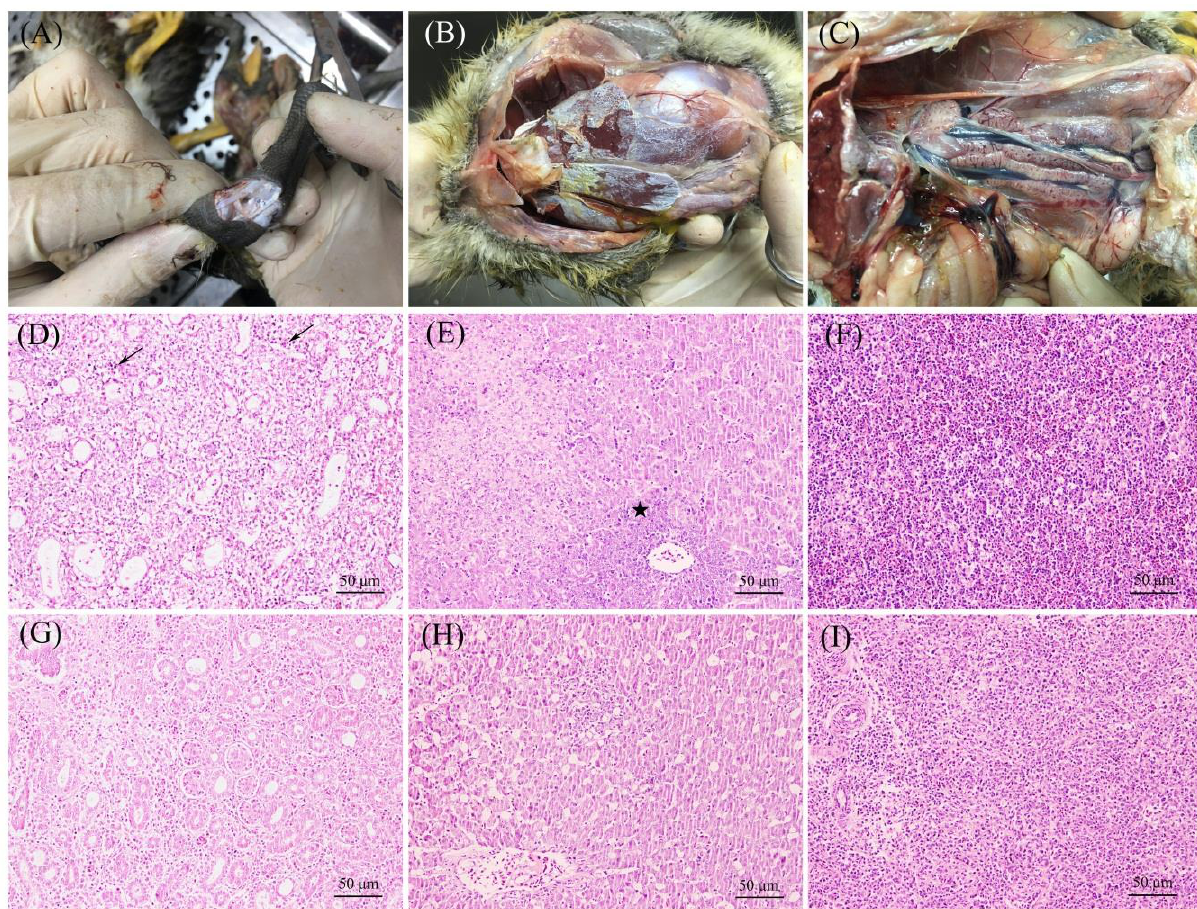
Figure 1. Postmortem lesions and histopathologic changes of goslings presented with gout clinical signs. ( A – C ) Urate deposits in the joints and ureter, on the surface of livers, and swelling of the kidneys. ( D ) Swelling of glomeruli and necrosis of renal tubular epithelial cells, as well as inflam- matory cell infiltration (arrow) in kidneys (H&E). ( E ) Necrosis of hepatocytes and inflammatory cell infiltration (star) in the liver (H&E). ( F ) Splenic lymphocyte necrosis and hyperplasia (H&E). ( G – I ) Normal kidney, liver and spleen HE sections of an uninfected gosling